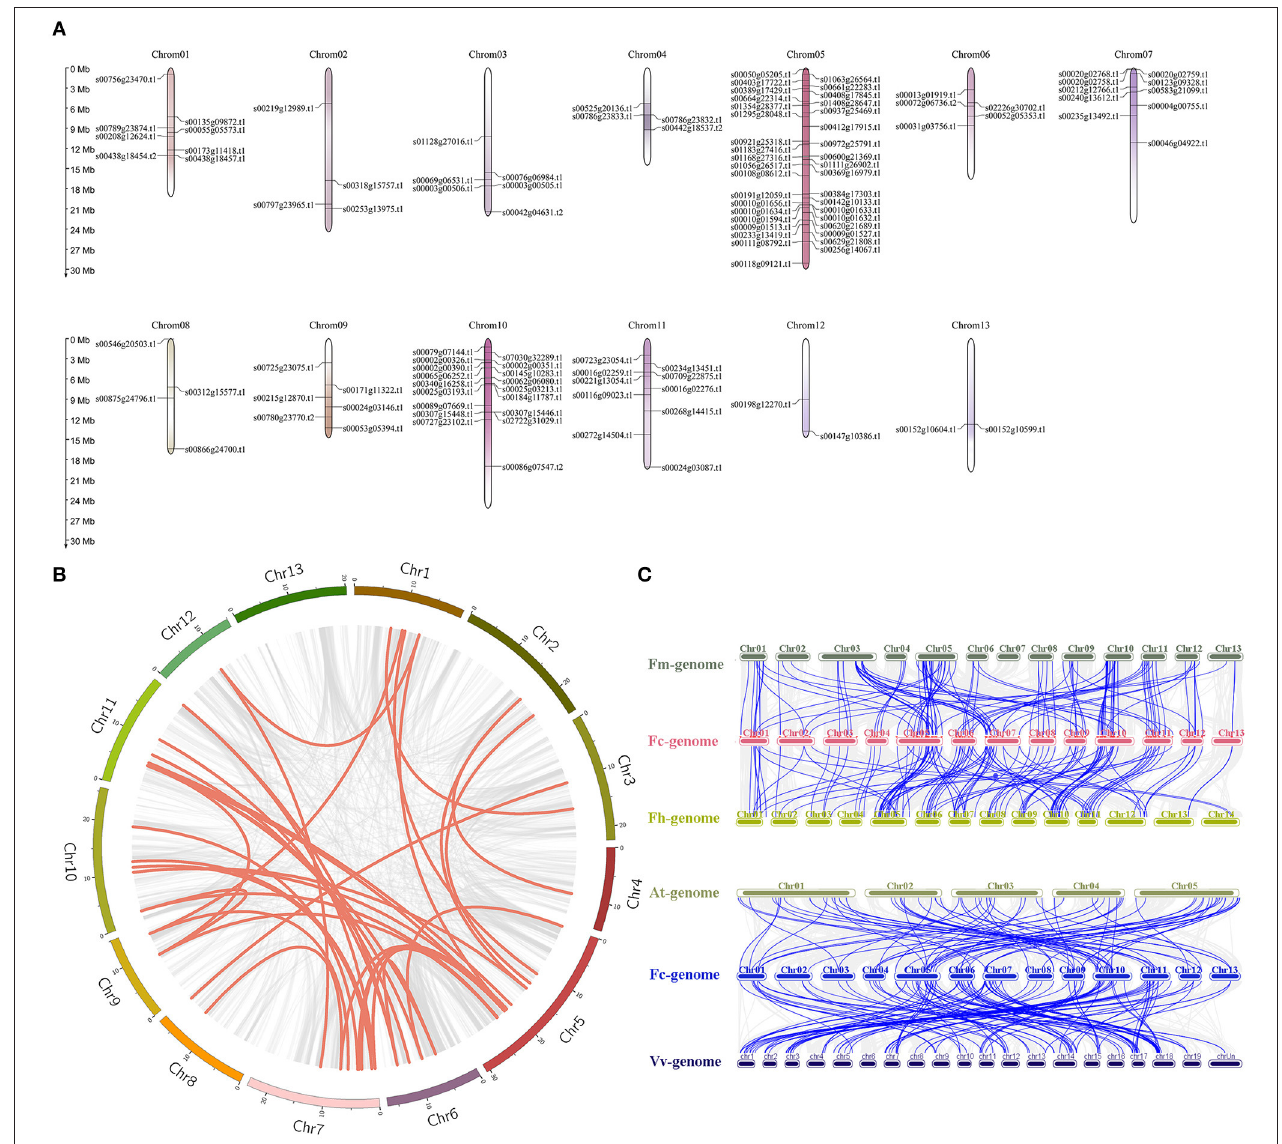
FIGURE 2 | Chromosomal locations and collinearity analysis of the FcbHLH gene family. (A) FcbHLH genes are marked on chromosomes; scale bar on the left indicates length of fig chromosome (Mb). (B) Collinearity analysis of FcbHLH genes; circle plot was created with the MCScanX tool. Identified collinear genes are linked by colored lines. (C) Collinearity relationship of bHLH genes among Ficus carica (Fc), Ficus hispida (Fh), Ficus microcarpa (Fm), Arabidopsis thaliana (At), and Vitis vinifera (Vv) . Identified collinear genes are linked by blue